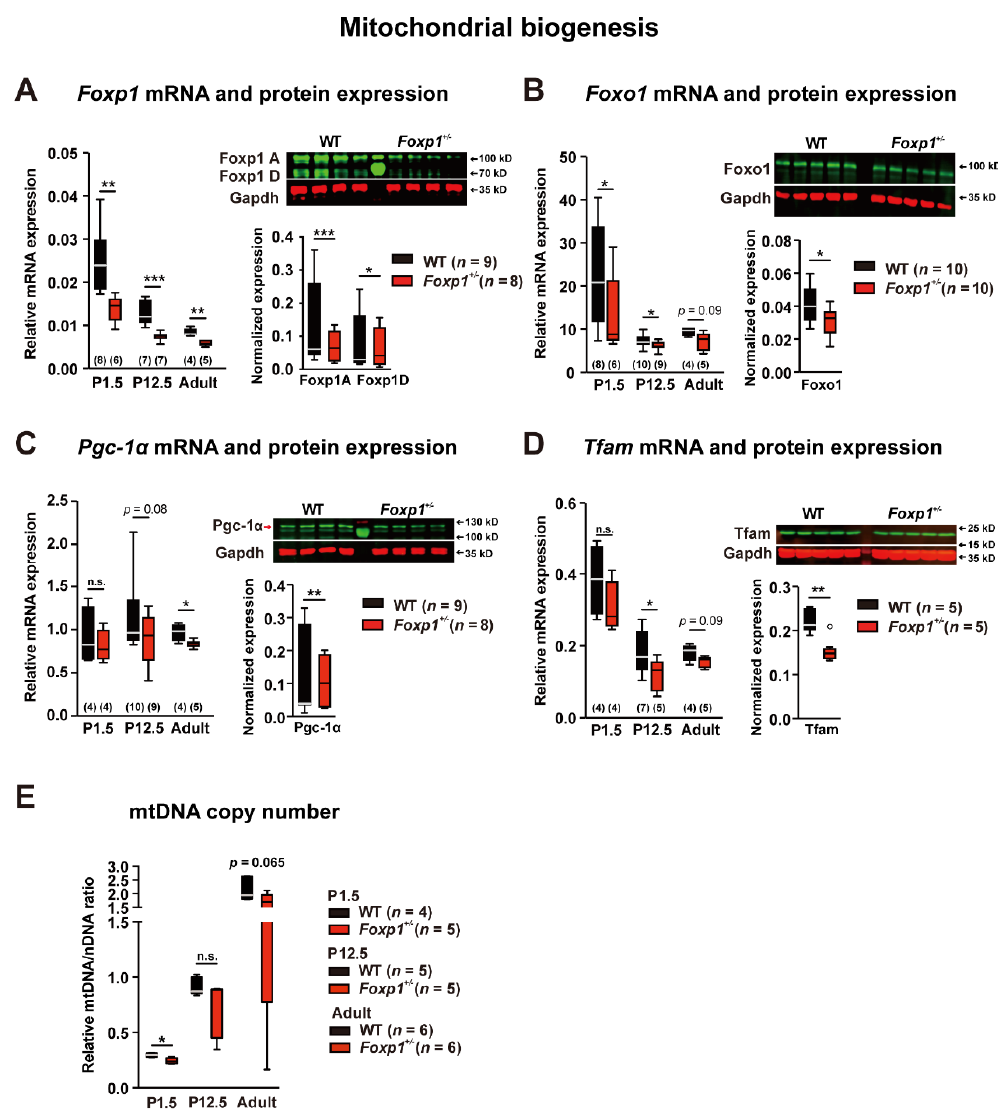
Figure 2. Impaired mitochondrial biogenesis in the Foxp1 +/− hippocampus. The mRNA levels of Foxp1 , Foxo1 , Pgc-1α , and Tfam were analyzed in WT and Foxp1 +/− tissue by quantitative real-time PCR at P1.5, P12.5, and adult stage. Protein expression of the four genes was quantified at adult stage by western blot ( A – D ). ( A ) Foxp1 mRNA levels were significantly reduced, by ~40%, at all three time points. The two Foxp1 isoforms present in the hippocampus, Foxp1 A and Foxp1 D, were decreased by ~50% and ~29%, respectively, in Foxp1 +/− tissue compared to WT. ( B ) Foxo1 mRNA levels were decreased in Foxp1 +/− mice at all three time points by ~40%, ~15% and ~25%, respectively and Foxo1 protein was reduced by ~29%. ( C ) At adult stage, Pgc-1α mRNA levels were ~14% lower and protein expression was reduced by ~23% in Foxp1 +/− tissue. ( D ) Tfam mRNA levels were reduced at P1.5, P12.5, and adult stages by ~20%, ~34%, and ~14%, and protein expression was reduced by ~29%. ( E ) To evaluate mitochondrial DNA copy number in WT and Foxp1 +/− tissues, mitochondrial DNA (mtDNA) and nuclear DNA (nDNA) were quantified by quantitative real-time PCR at P1.5, P12.5, and adult stages, and mtDNA/nDNA ratios were calculated. Reduced mtDNA/nDNA ratios in the Foxp1 +/− hippocampus at all three timepoints indicate a lower number of mitochondrial genomes per cell in Foxp1 +/− tissue compared to WT. The exact number of animals tested per group is indicated in the figure. Weak outliers are marked with a circle. Asterisks indicate a significant difference (* p ≤ 0.05, ** p ≤ 0.01, *** p ≤ 0.001); n.s. indicates non-significant; two-way ANOVA.